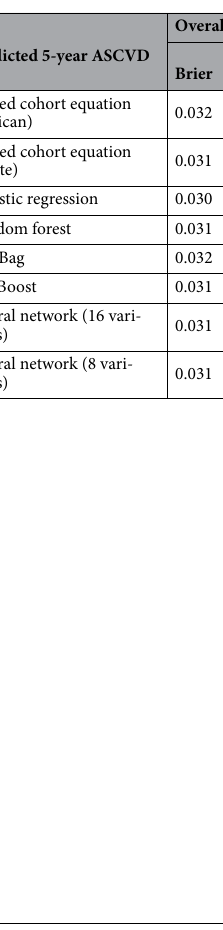
Predicted 5-year ASCVD risk